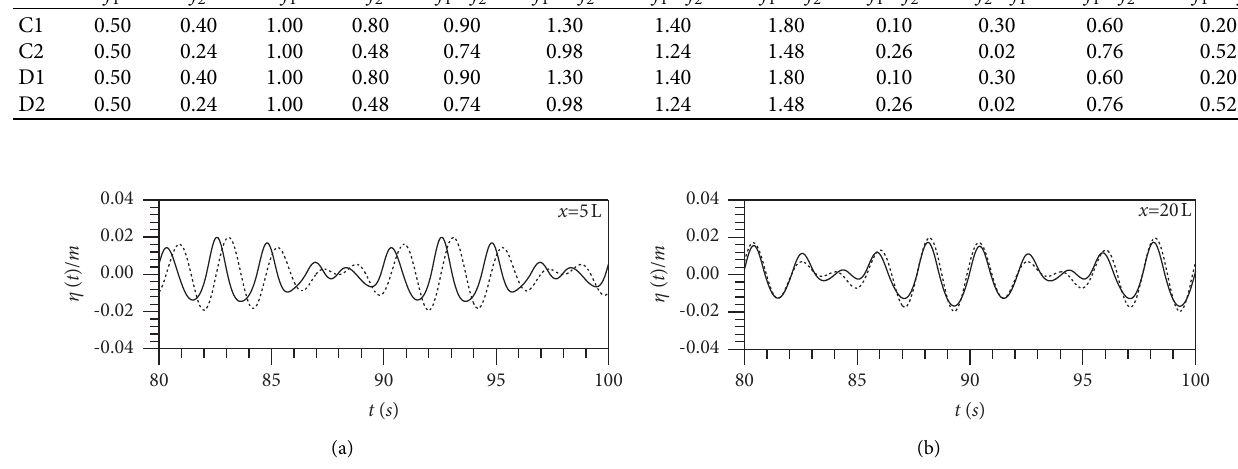
Figure 2: Comparisons of the wave profiles between the calculation results (solid line) and theoretical results (dashed line) at different gauge locations for case C1.